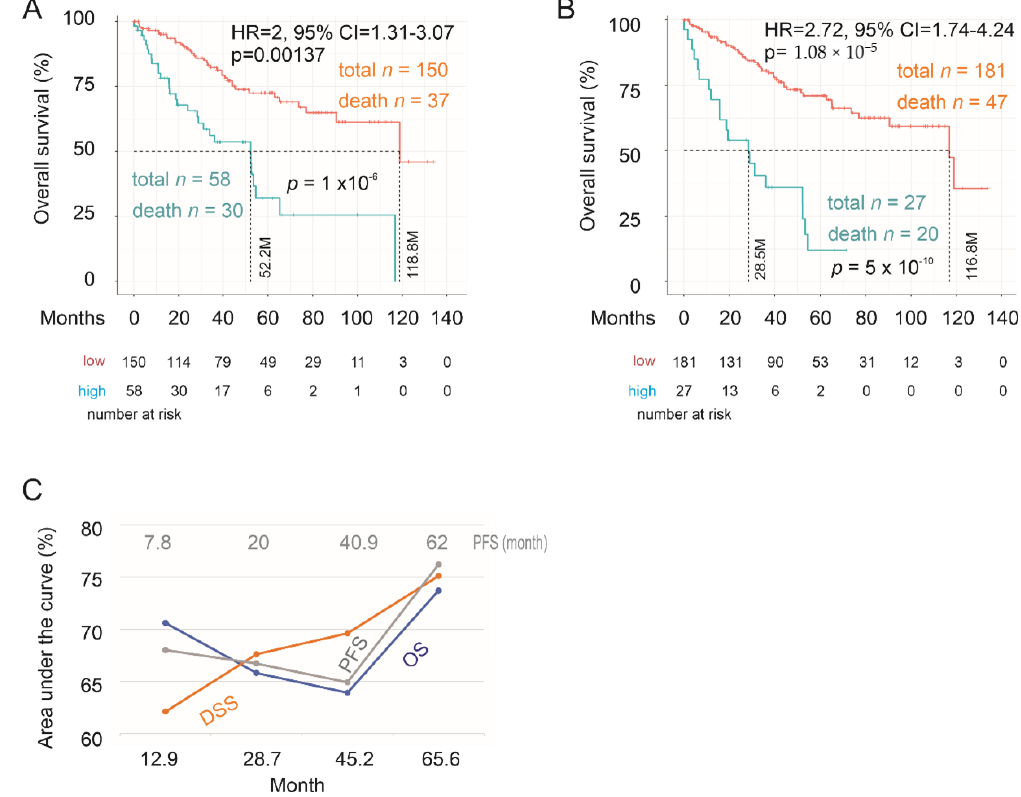
Figure 4. SigIQGAP1NW efficiently predicts the risks of poor prognosis of ccRCC in the testing population. ( A , B ) Analyses of the fatality risk of ccRCC using SigIQGAP1NW scores defined from the training population ( A ) or the testing cohort ( B ). HR, 95% CI, and p values along with logrank p value for Kaplan Meier survival curves are provided. The respective median survival times are also indicated. ( C ) Time-dependent ROC curve. Months for PFS are specifically labeled.